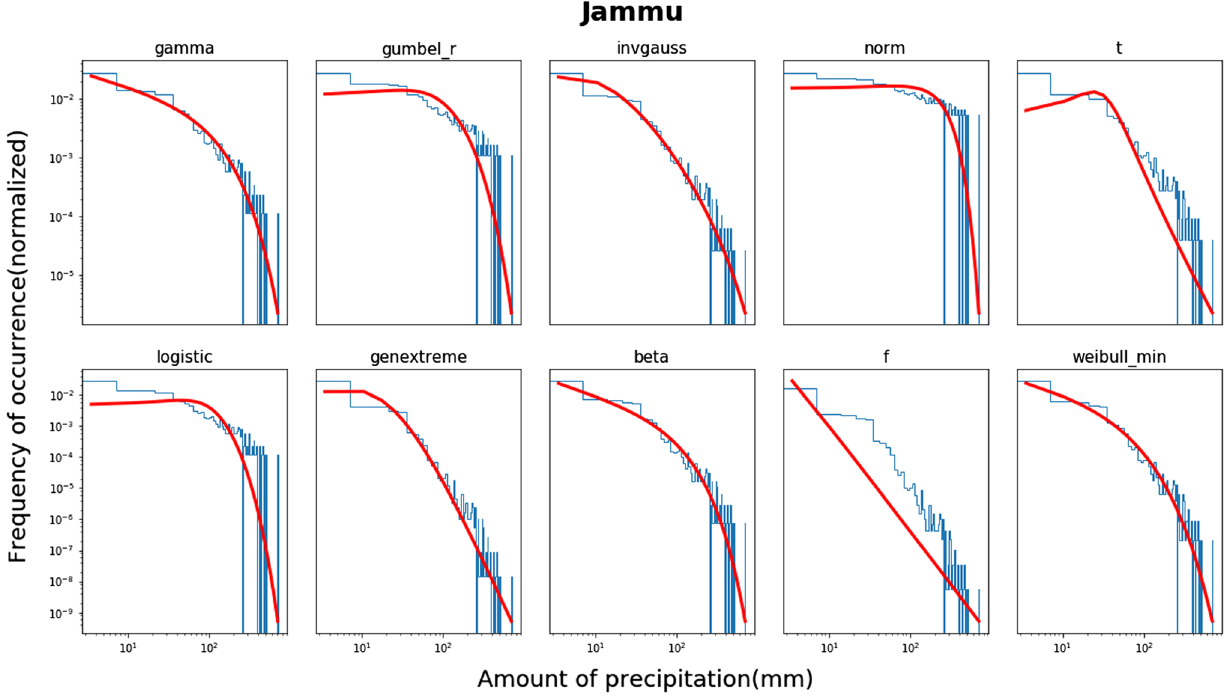
Fig. 4 Histogram of the monthly precipitate data at Jammu (blue lines) along with best fit for each of the 10 probability distributions functions